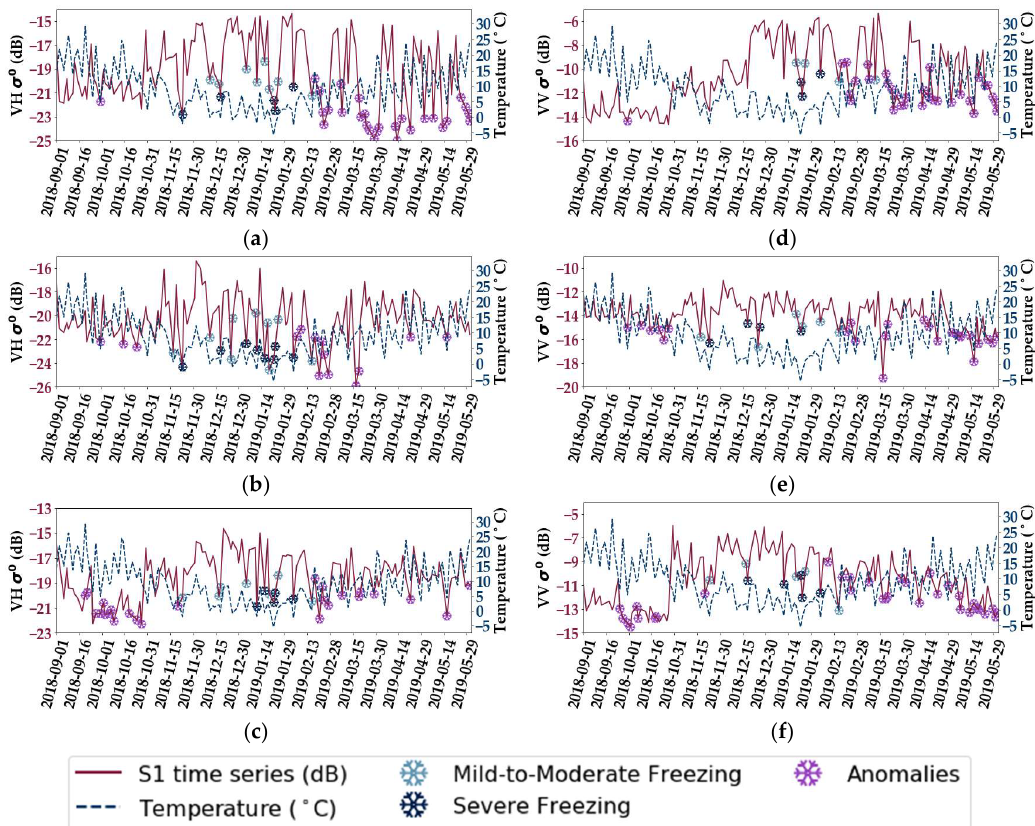
Figure 9. Freezing detection over one reference plot by land cover class in site B for each S1 acquisition date, using VH and VV polarizations. ( a ) VH-LC1, ( b ) VH-LC2, ( c ) VH-LC3, ( d ) VV-LC1, ( e ) VV-LC2, ( f ) VV-LC3.